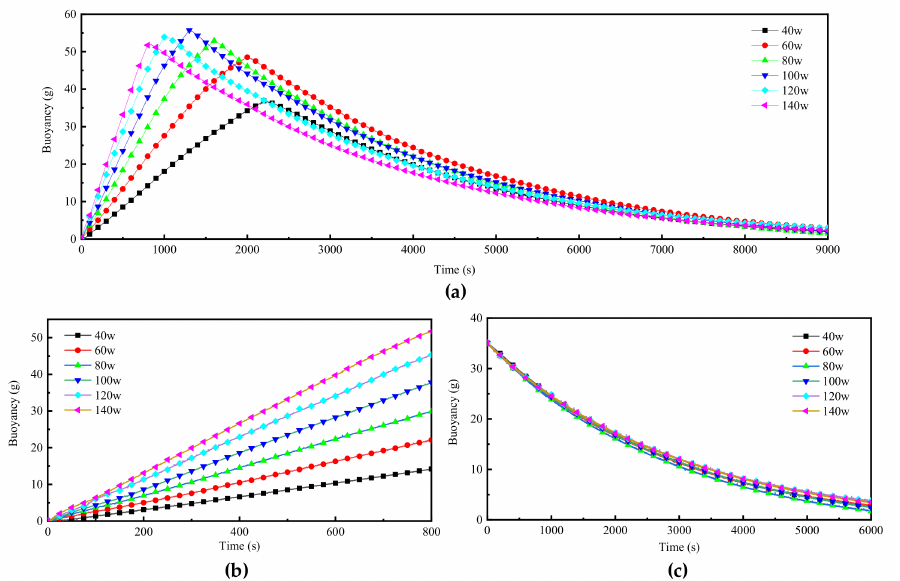
Figure 12. Experimental results of BCM in flume: ( a ) the buoyancy change monitoring of the BCM under di ff erent power; ( b ) buoyancy change monitoring of BCM running under di ff erent power within 800 s; ( c ) drop curve of buoyancy starting from 35 g under the natural cooling